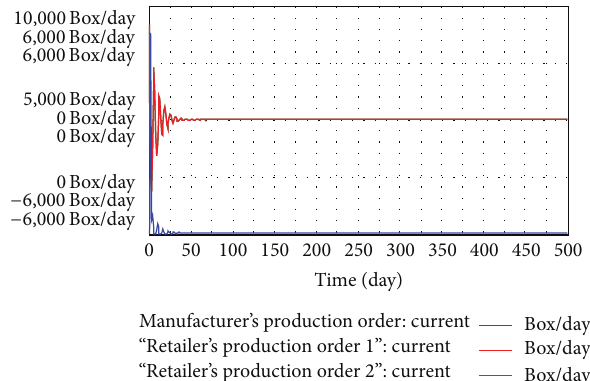
Figure 10: Changes of the order quantity of each member when recycled product delay time is